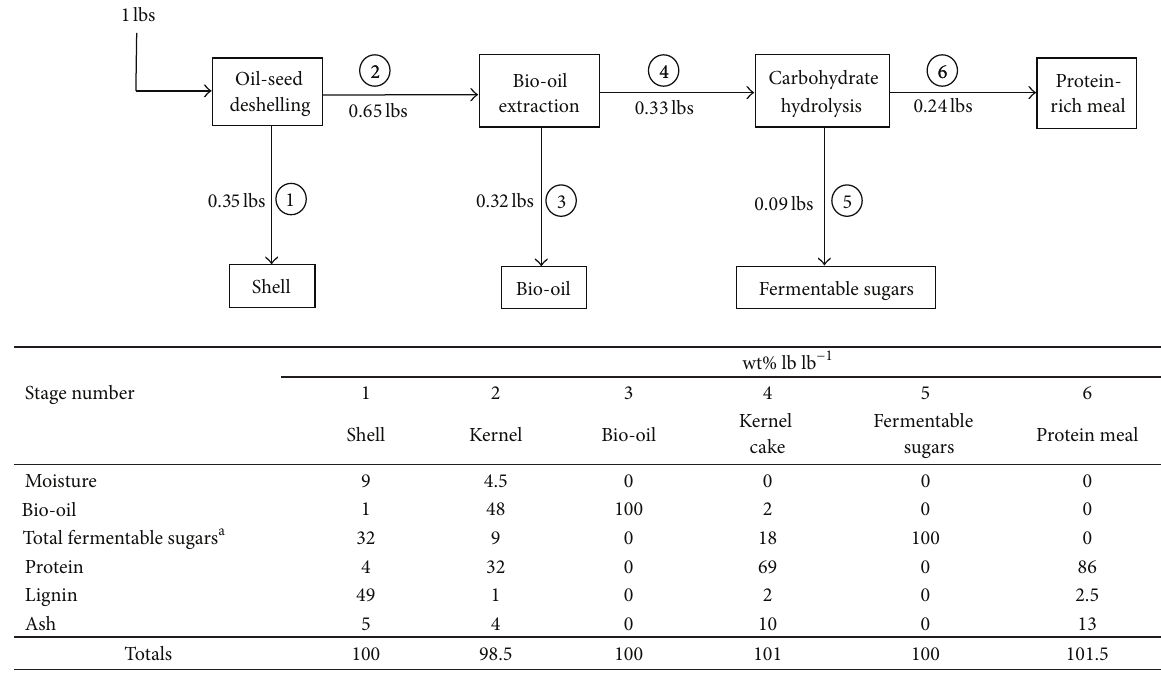
Figure 7: Mass balances for solvent extraction of jatropha kernel and the composition of intermediate stages. Whole jatropha seed taken to comprise moisture (6%), bio-oil (32%), total fermentable sugars (18%), protein (19%), lignin (17%), and ash (6%). The values in table are averages taken from the literature and consequently do not always sum to precisely 100